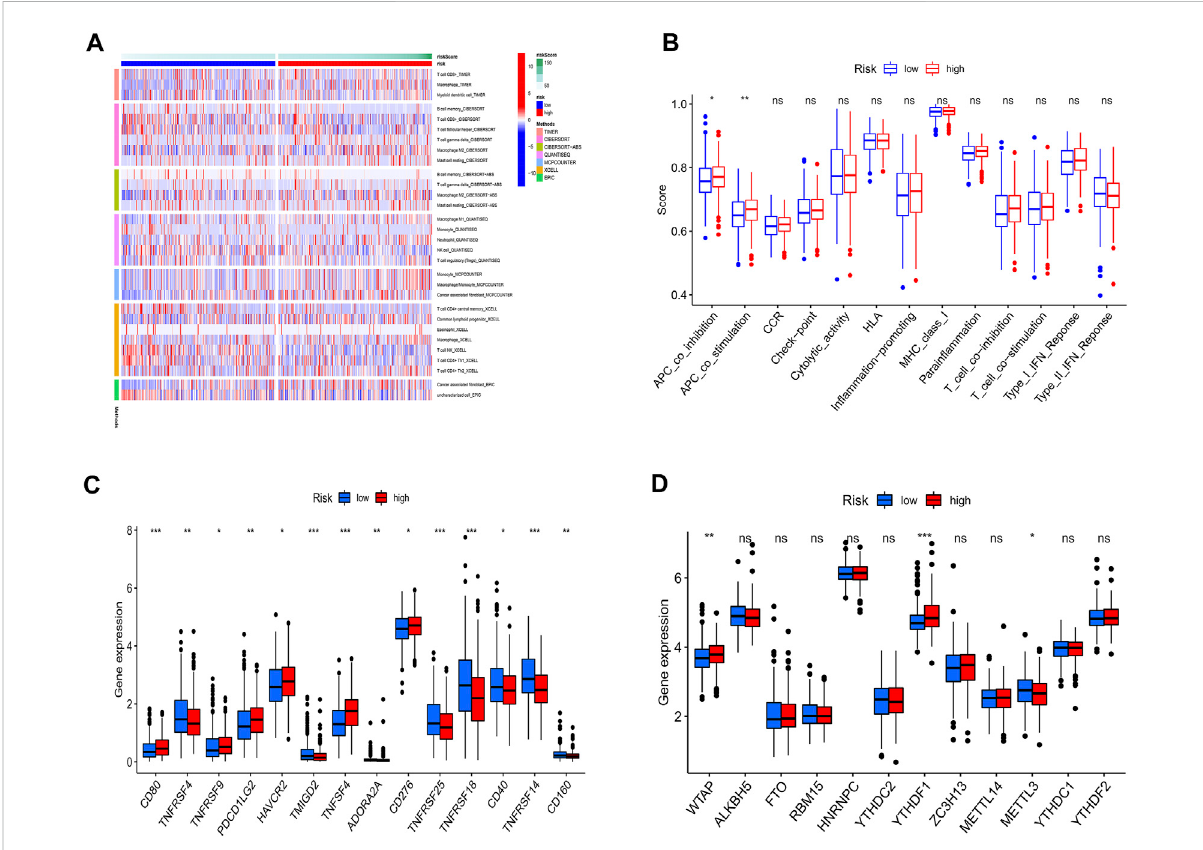
FIGURE 7 Immunoassay and m6A analysis. (A) Immune cell in fi ltration distribution. T cells, B cells, and Macrophage tended to be highly expressed mainly in the high-risk group. (B) Immune-related functions. The high-risk groups have a more active immune function. (C) The expression of immune checkpoint-related genes. The majority of immunological checkpoint genes were up-regulated. (D) the expression of m6A-related genes. In high- risk groups, most m6a-related genes were